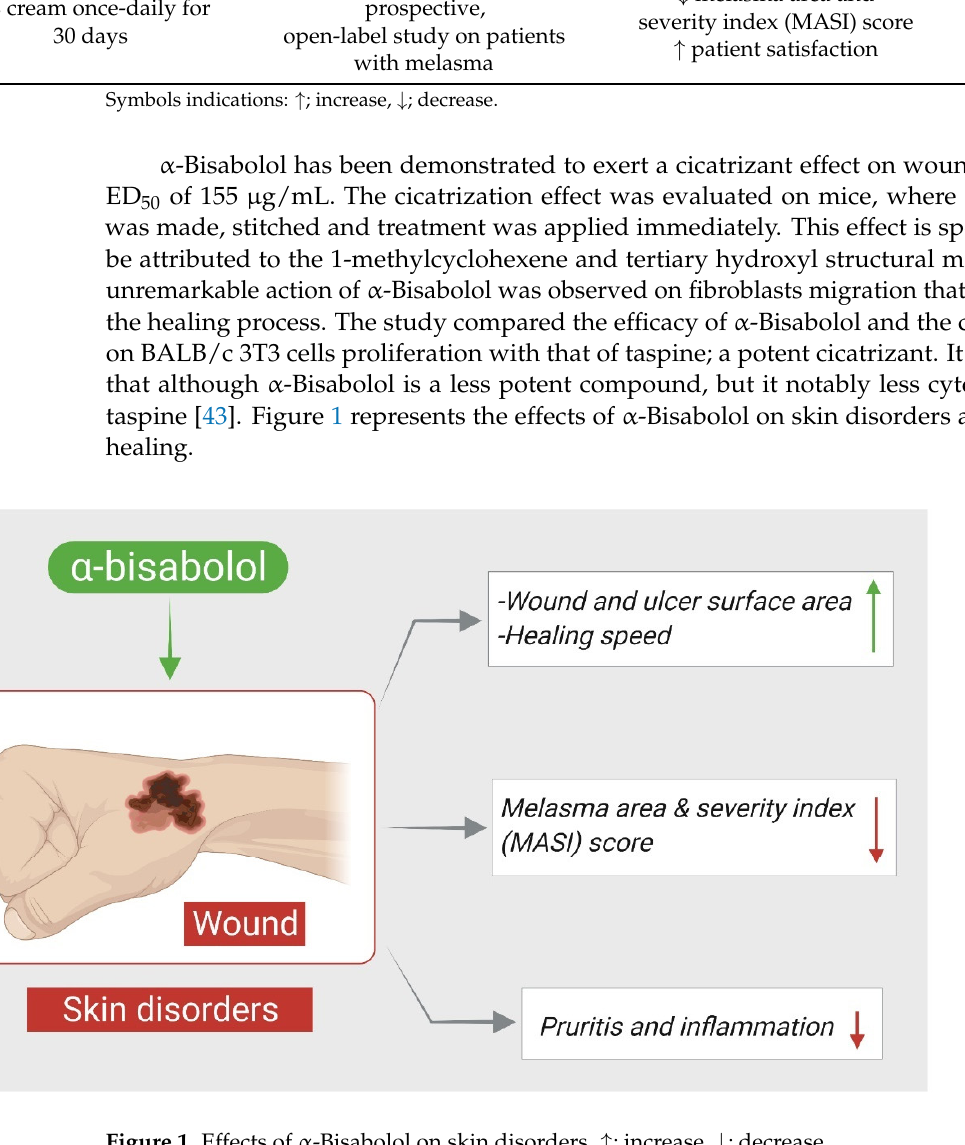
Table 3. Therapeutic effects and demonstrated mechanisms of α‐ Bisabolol in skin disorders.